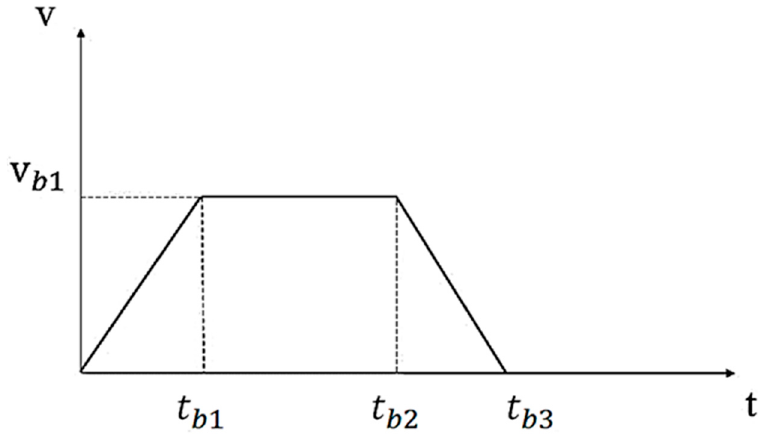
Figure 3. Cycle B of an EV.